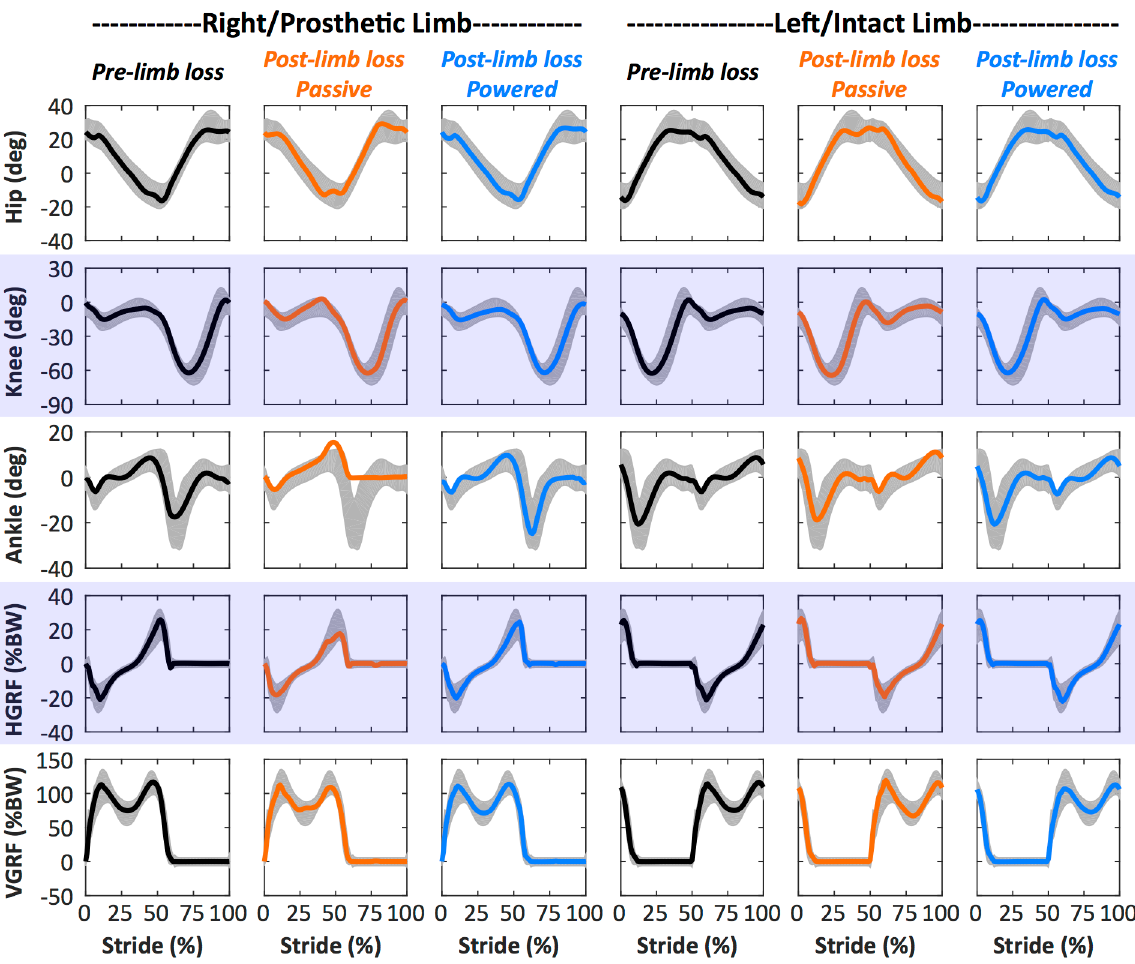
Fig 4. Example gait mechanics. Gait kinematics (hip, knee, and ankle angles) and kinetics (horizontal and vertical ground reaction forces, HGRF and VGRF) of Subject 01’s walking simulations with the pre-limb loss model (columns 1 and 4), and with the post-limb loss model using the passive prosthesis (columns 2 and 5) and the powered prosthesis (columns 3 and 6). The post-limb loss model had no strength loss. The stride begins at heel-strike of the right/residual limb. The shaded area in each panel is ± two standard deviations around the mean of experimental data for N = 14 healthy adults without limb loss